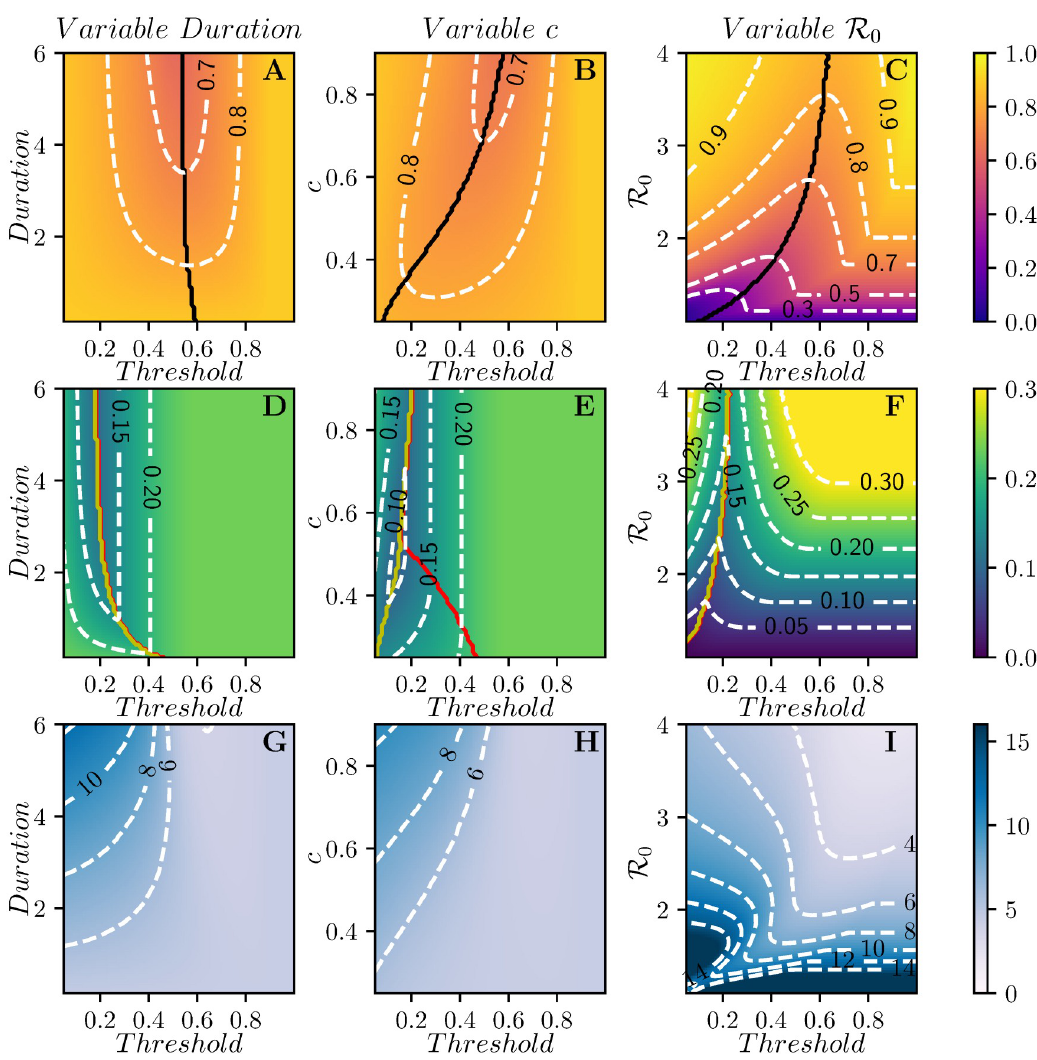
vary from 1 to 4. In all cases γ = 1. In the first row, the black curve denotes the threshold for which R R 0 intervention completes. In the three regions defined by the two lines in the panels of the second row, the peak prevalence is observed after the intervention has ended (from left to yellow curve), during intervention (area between the curves), or before intervention (from red curve to the end of the figure). Where the two curves align, the prevalence decays as soon as the intervention is implemented and then recovers to the pre-intervention